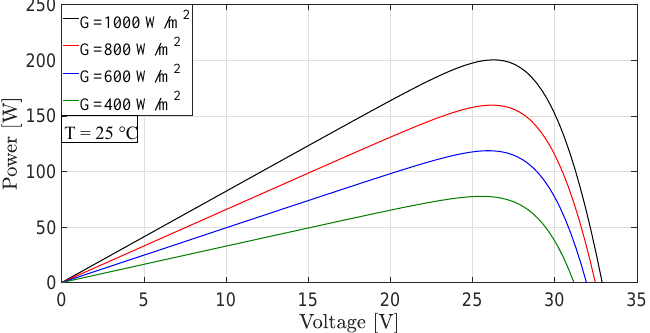
Figure 1. P-V characteristics of the PV source under uniform solar radiation conditions.